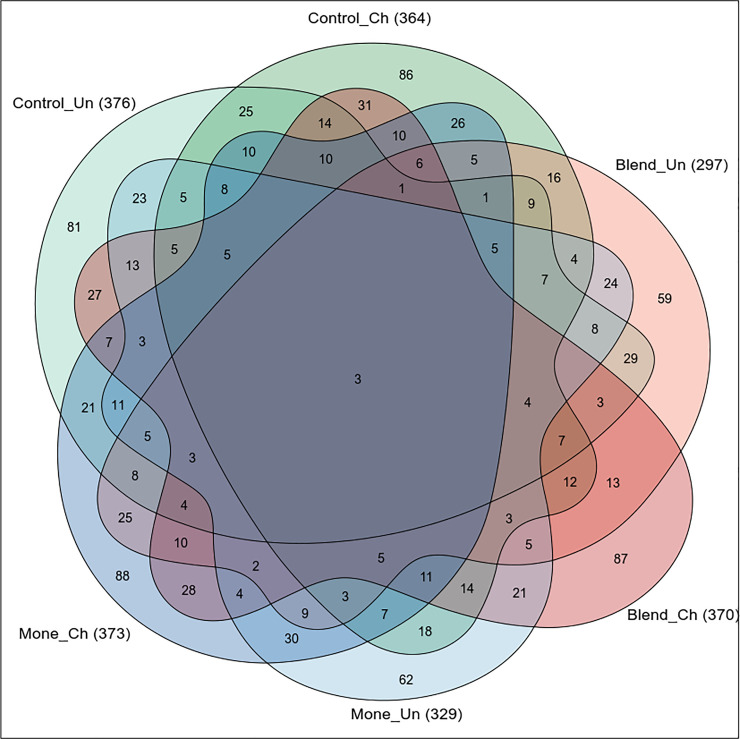
Common and unique variations in sequence amplification (ASVs) in broilers receiving three feed additives, basal diet (control), sodium monensin (Mone), or blend and challenged (CH) or not challenged (UN) with coccidiosis.The Venn diagram shows the numbers of ASVs that are shared or not shared by the six treatments, depending on the overlaps.